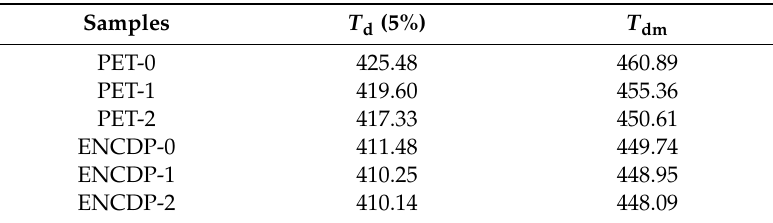
Figure 7. ( a ) Thermogravimetric analyzer (TGA) curve and ( b ) dTGA curve of samples. Table 9. Thermogravimetric data for the